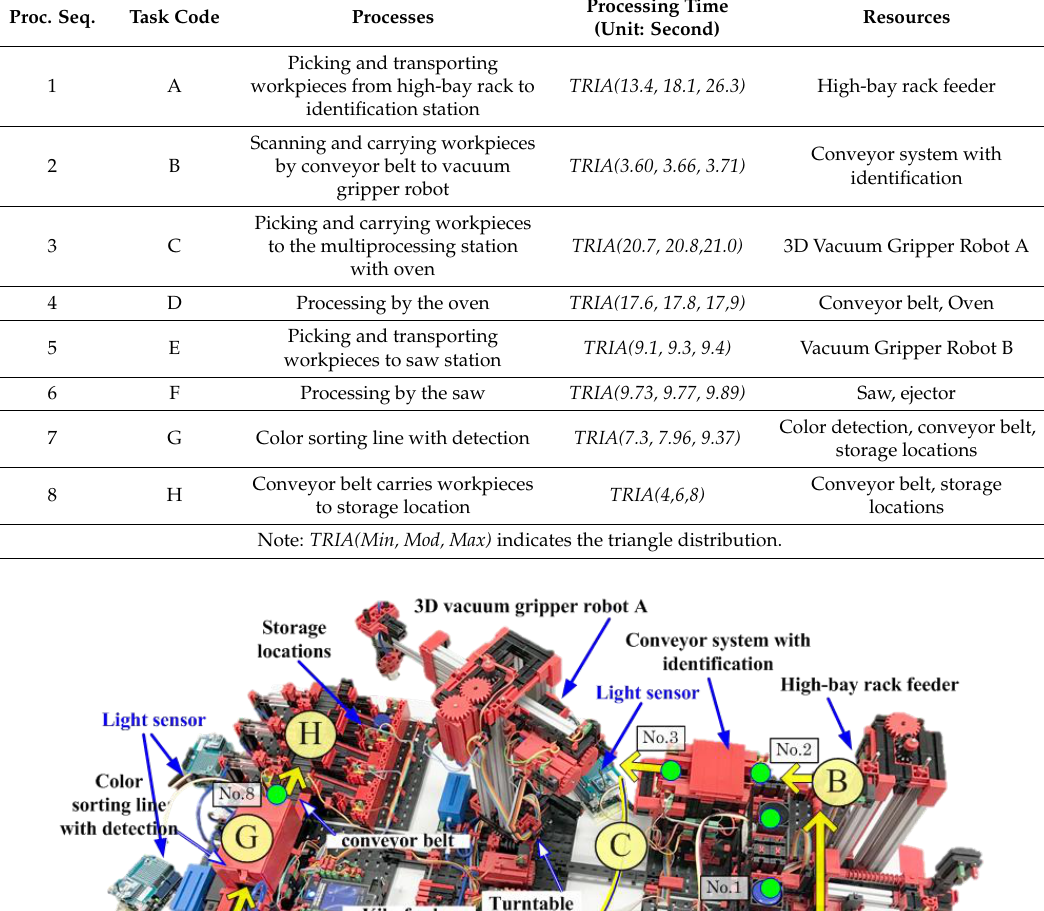
Table 1. Process schedule and processing parameters in the factory model.